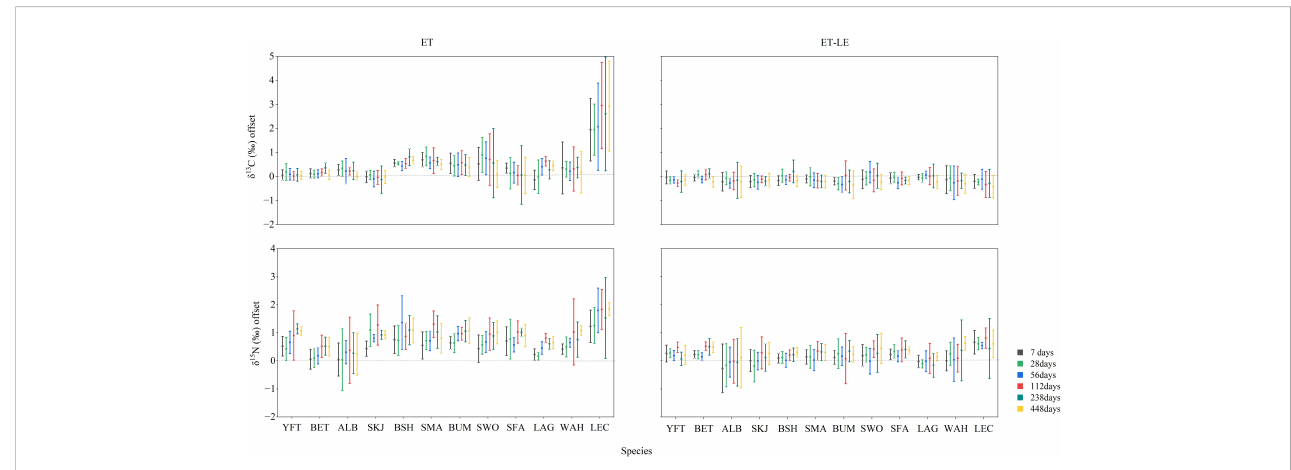
FIGURE 2 The d 13 C and d 15 N offsets for all treatments (ET, ET+LE) in muscle tissue across each